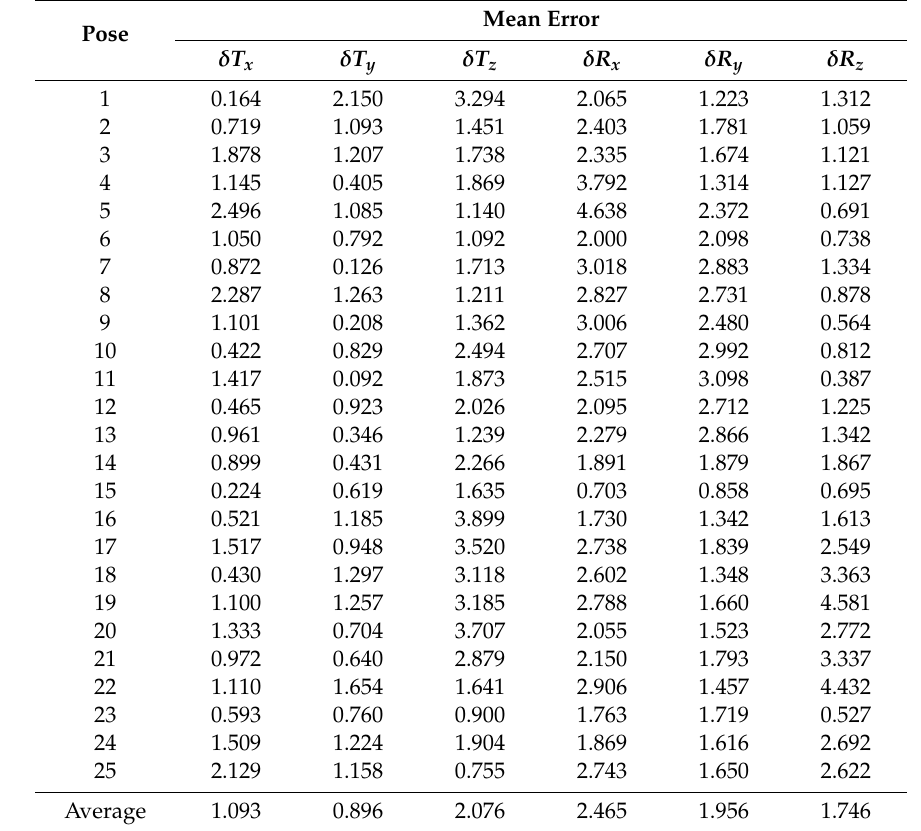
Table 5. Absolute error per pose, with 20 tests per pose for the front side. Results in mm for translation error and in degrees for rotation error.